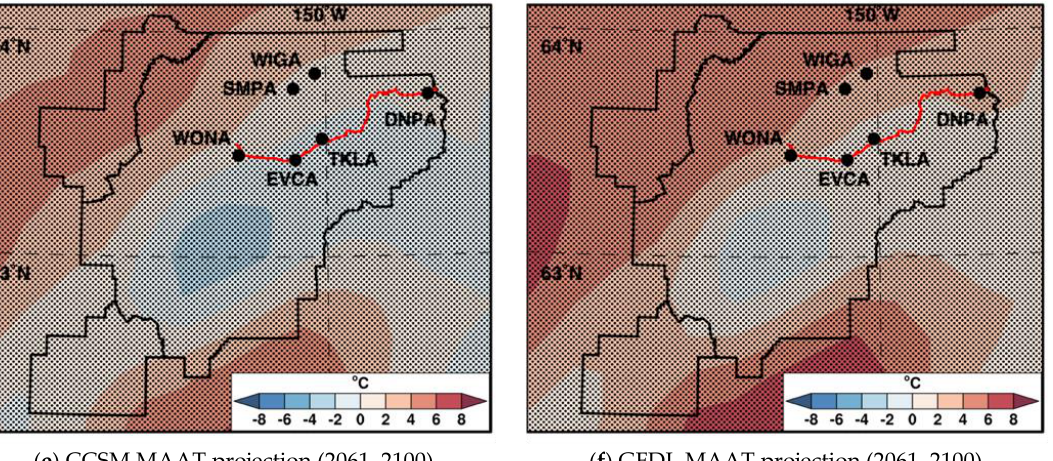
Figure 8. Denali National Park ( a ) ERA5 mean annual air temperature (MAAT) climatology (°C), ( b ) park-average (left) and road corridor (right) boxplots of MAAT, and bias-corrected: mid-century MAAT projections from ( c ) CCSM and ( d ) GFDL and late-century MAAT projections from ( e ) CCSM and ( f ) GFDL. All projections are significant at the 95% confidence level (shaded with stippling).